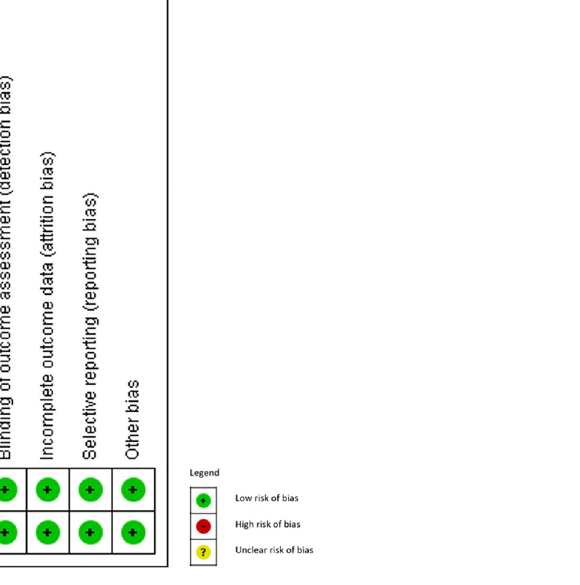
Fig 3. Risk of bias in RCTs. RCT, randomized controlled